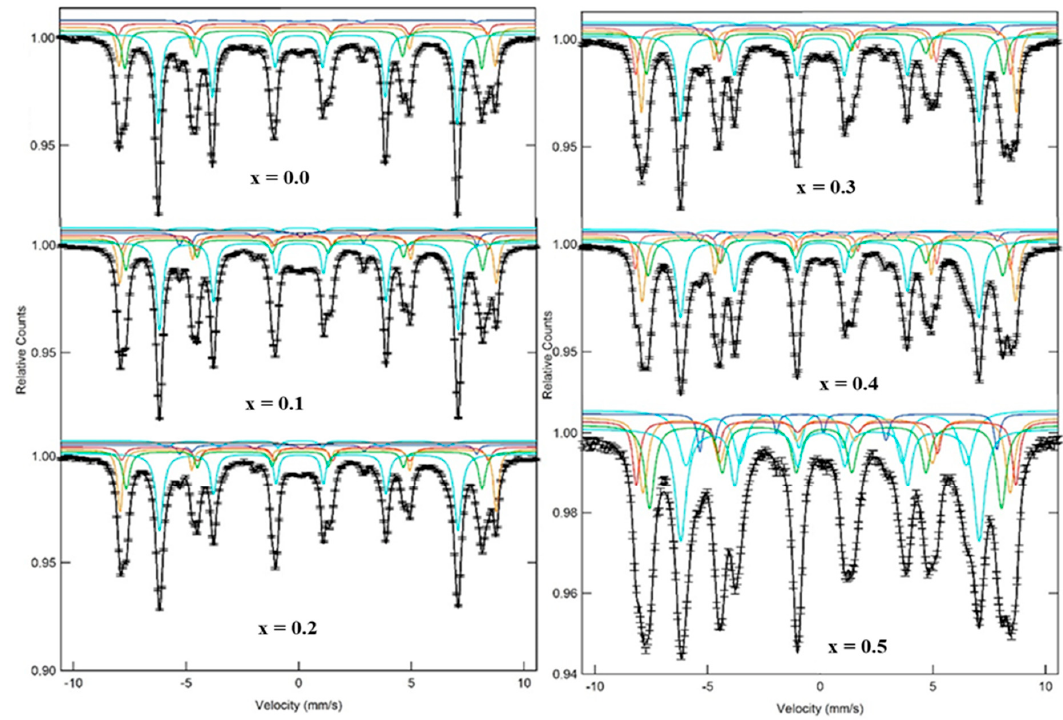
Figure 6. Room temperature Mössbauer spectra of all studied Sr 1 − x Mn x Fe 12 − x Y x O 19 (x = 0.0, 0.1, 0.2, 0.3, 0.4 and 0.5) nanohexaferrites.